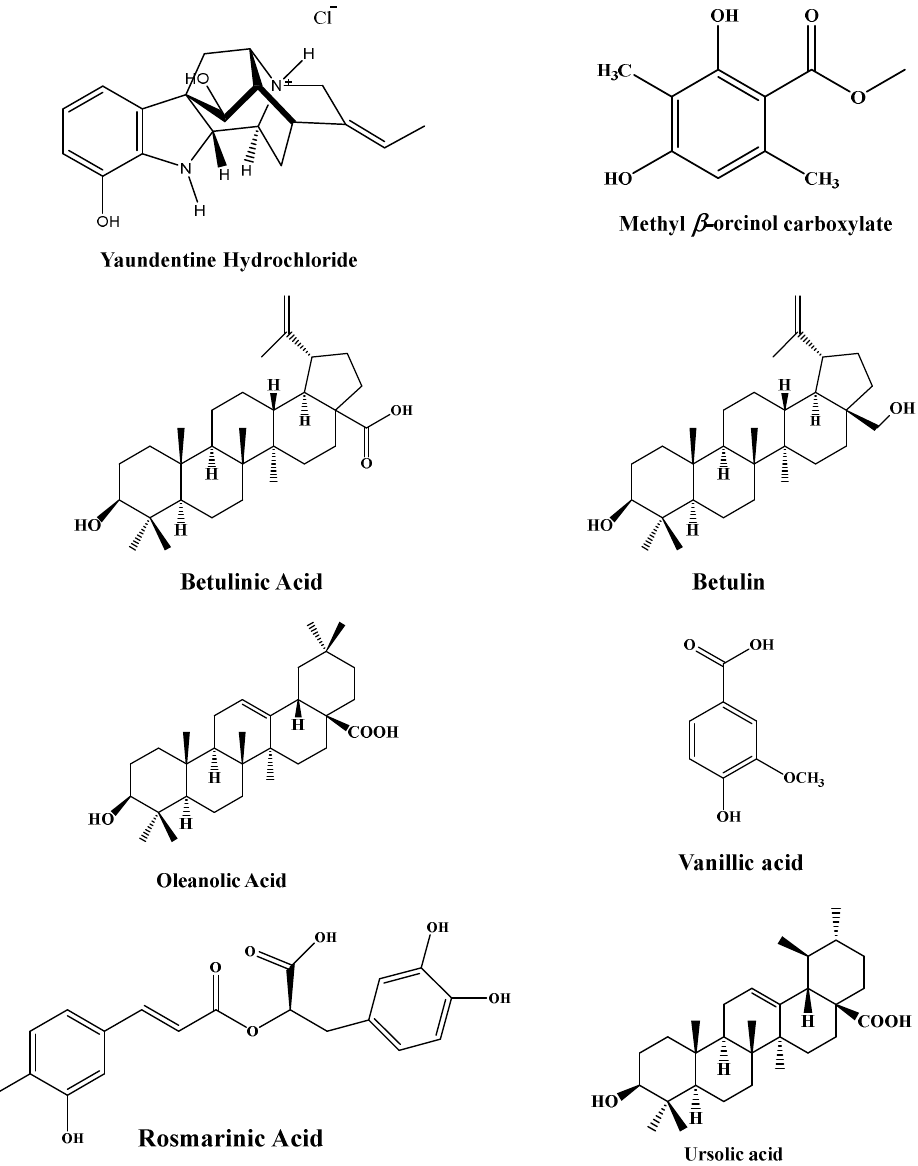
Figure 1. Compounds and their structures isolated from medicinal plants.